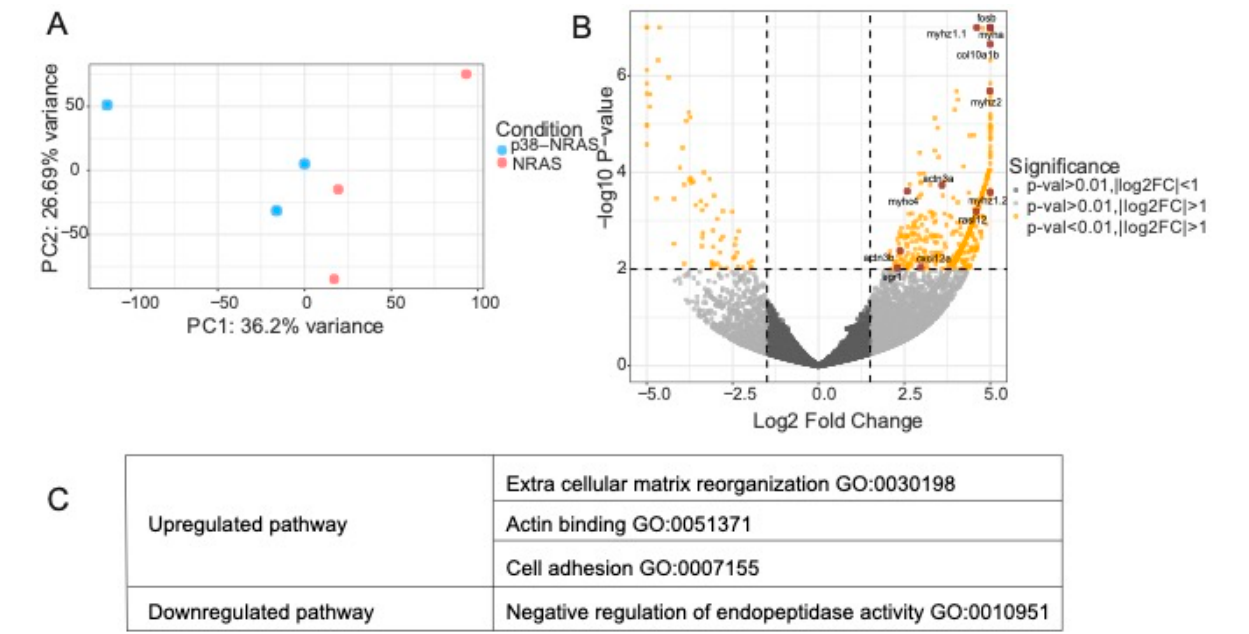
Figure 8. RNA sequencing analysis of p38–NRAS Q61K -and NRAS Q61K -derived zebrafish tumor tissues. ( A ): Principal component analysis of p38–NRAS Q61K tumors compared with NRAS Q61K tumors (normalized + log2). ( B ): Volcano plot showing differentially expressed genes (DEGs) in p38–NRAS Q61K tumors compared with NRAS Q61K tumors (raw threshold; 0.01). Most upregulated and downregulated pathway by over-representation analysis (ORA, p -value < 0.01). ( C ): Most upregulated and downregulated pathways in tumors derived from p38– NRAS Q61K compared to NRAS Q61K as represented by ORA , p -value < 0.05.